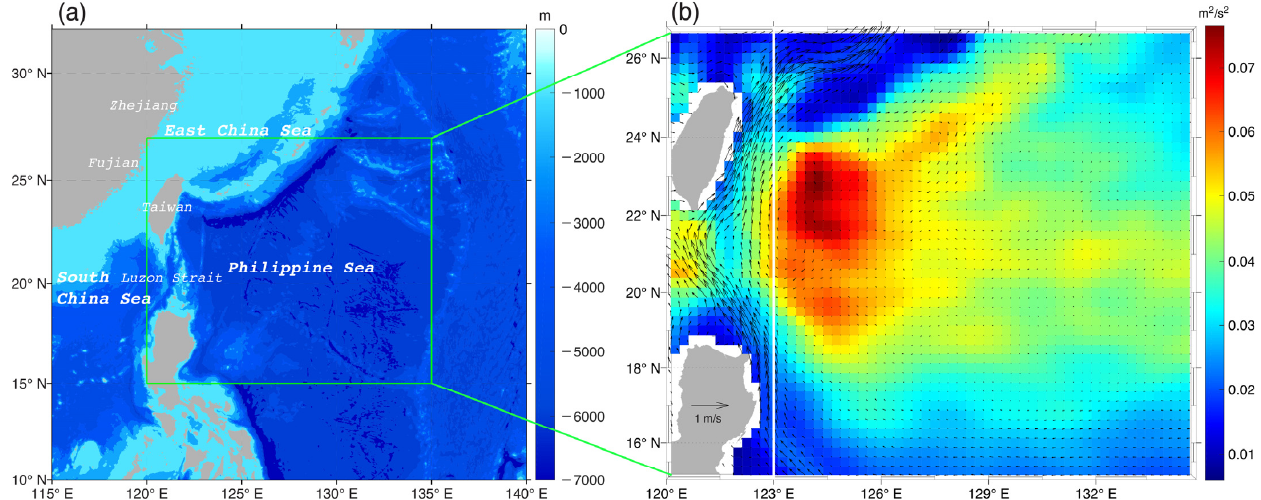
Figure 1. ( a ) Bathymetry (m) of the northwest Pacific Ocean. ( b ) Mean surface geostrophic current (black arrows) and eddy kinetic energy (EKE, m 2 /s 2 ) in the vicinity of the Kuroshio from the 25-year AVISO altimeter data. The white line represents the boundary of the regions where the eddies interact with the Kuroshio or not.